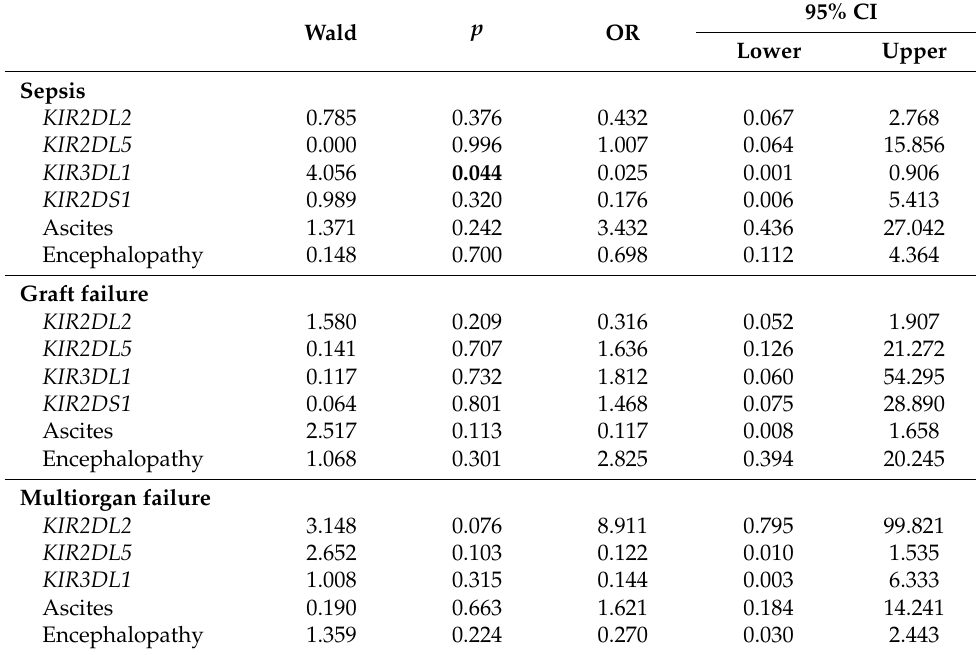
Table 3. Logistic regression multivariable analysis for main causes of death. Wald p